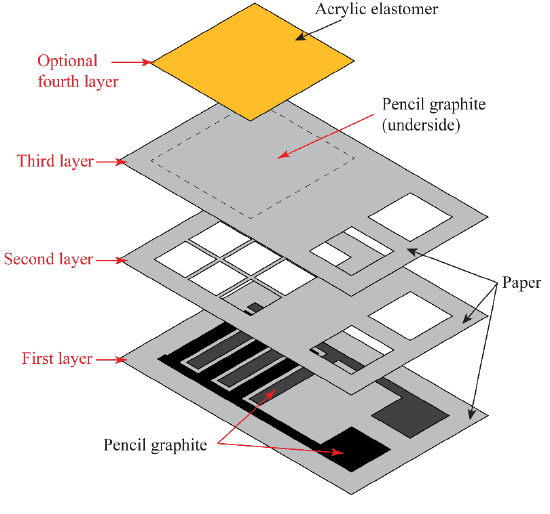
Figure 3. Assembly of the sensor.